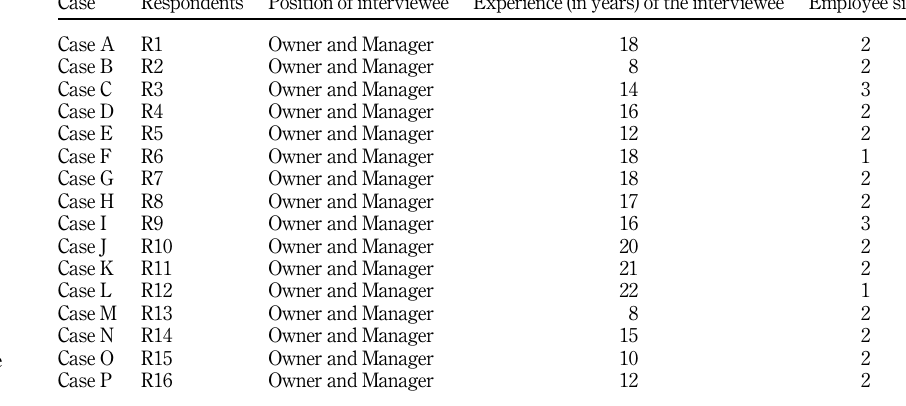
Table 1. Profile of the case